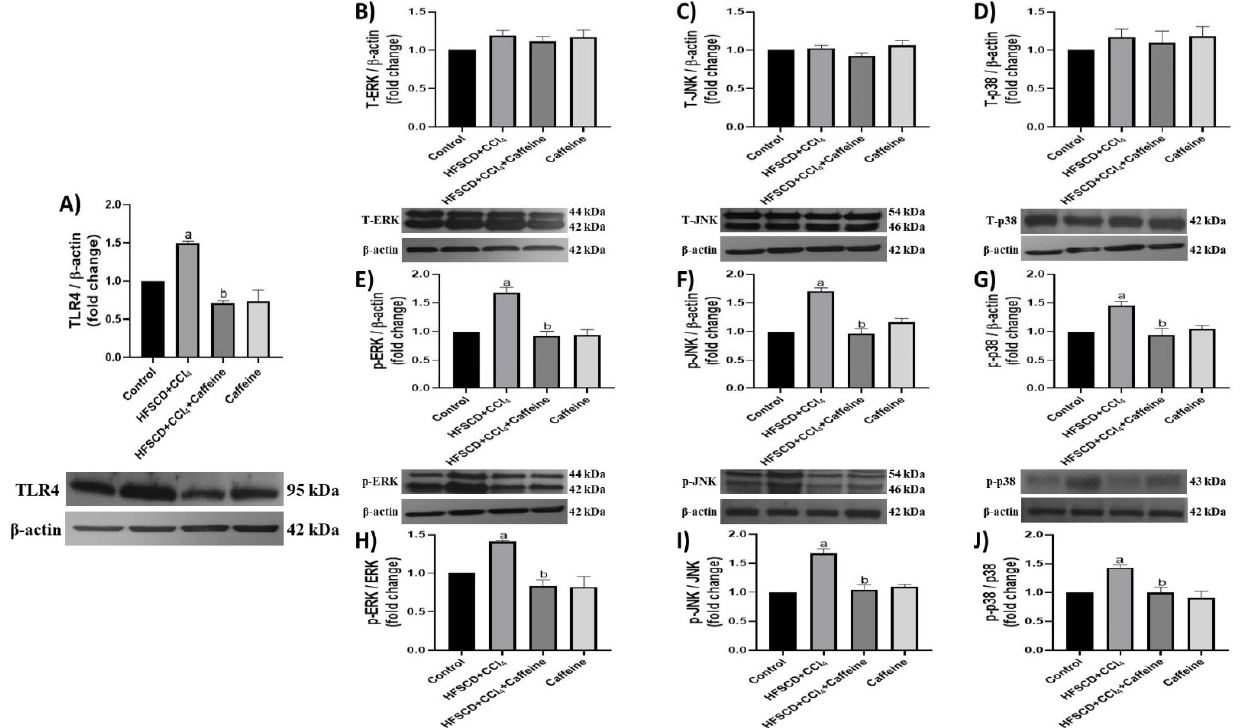
Figure 3. Effect of caffeine on the TLR4/MAPK pathway of hepatic tissue from the NASH model. Protein levels of TLR4 ( A ), ERK ( B ), JNK ( C ), p38 ( D ), p ‐ ERK ( E ), p ‐ JNK ( F ), and p ‐ p38 ( G ) in the hepatic tissues from rats in the control, HFSCD+CCl 4 , HFSCD+CCl 4 +caffeine, and caffeine groups were determined using western blot analysis. Bars represent the mean of experiments performed in duplicate ± SEM (n = 3); β‐ actin was used as a loading control. p ‐ ERK/ERK ( H ), p ‐ JNK/JNK ( I ), and p ‐ p38/p38 ( J ) ratios. Values are shown as a fold increment in optical density normalized to control group values (control = 1). Bars represent the mean of experiments performed in duplicate ± SEM.